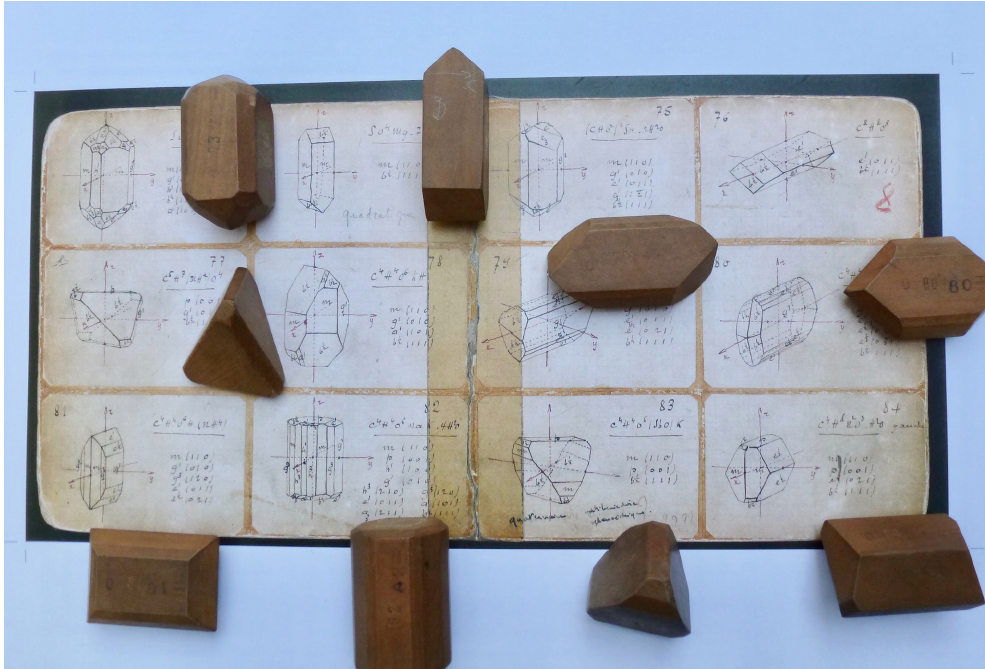
Figure 3. Example of a cardboard sheet (20 × 15cm) with corresponding drawings, indications and models.